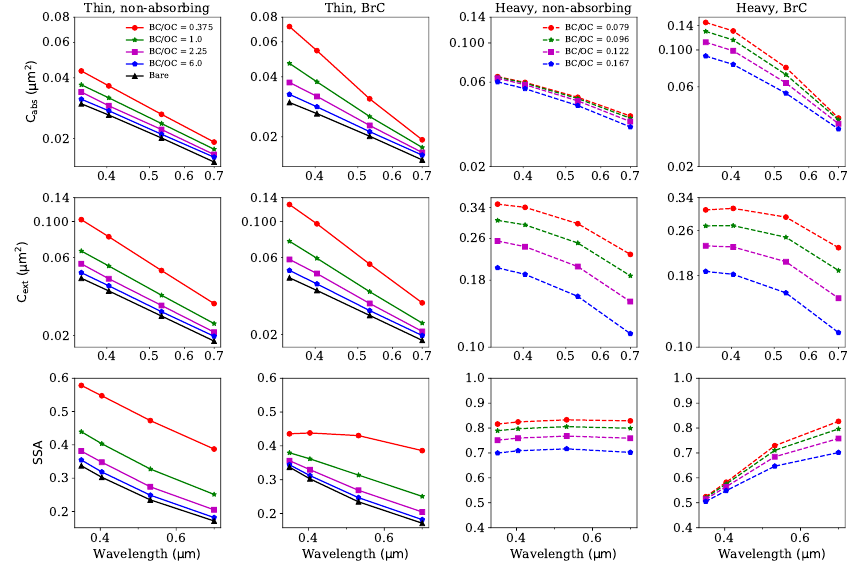
Figure 8. The wavelength dependences of radiative properties of BC at different mixing states, r g = 0.06 µ m, σ g =